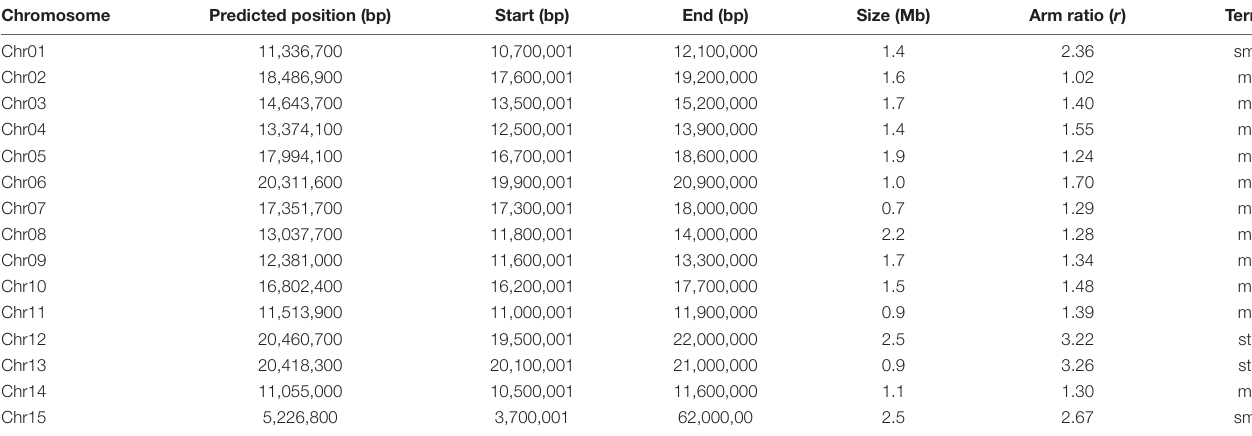
TABLE 2 | A summary of centromere regions and chromosome types for each chromosome. Chromosome Predicted position (bp) Start